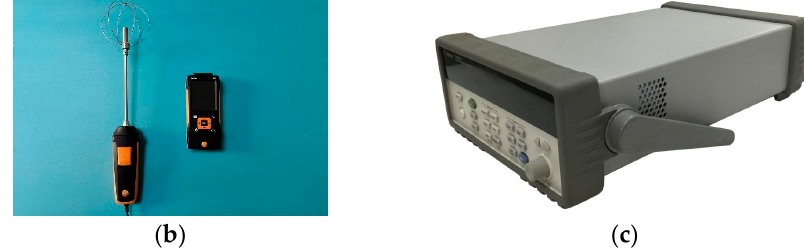
Figure 3. Physical view of the measurement instrument: ( a ) T-thermocouple; ( b ) Testo 480 hot-line anemometer; ( c ) Agilent. anemometer; ( c ) Agilent.